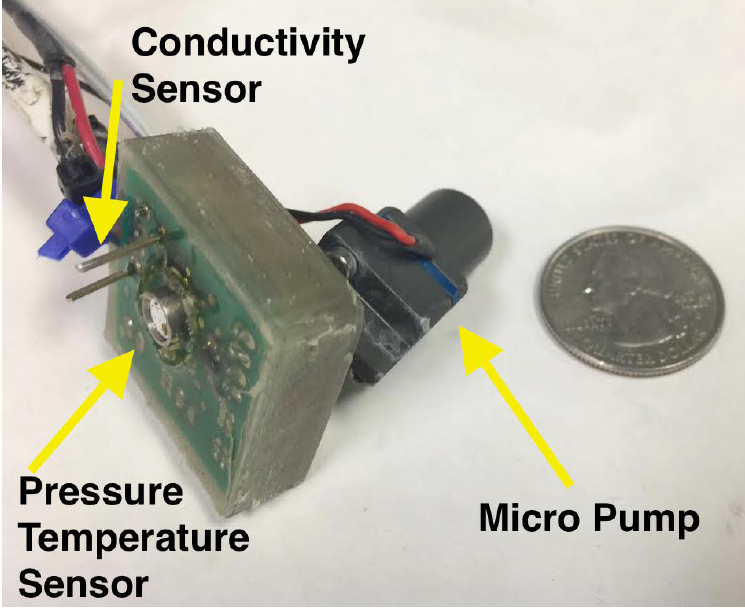
Figure 2. Detail of the pressure-temperature embedded sensor system contained at the end of the UAS tube. A U.S. quarter piece is shown for